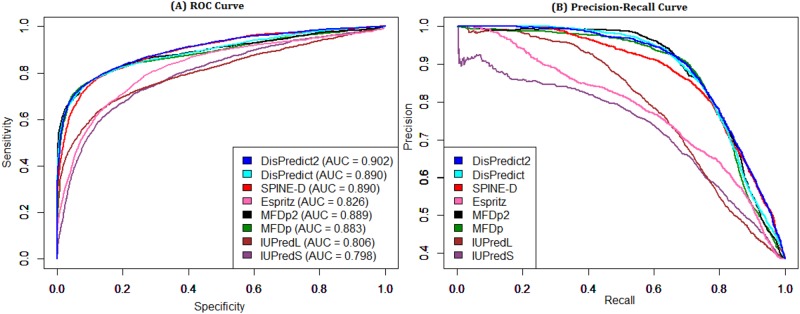
ROC and precision-recall curves given by 8 disorder predictors for DD73 dataset.Comparison of disorder predictors in terms of (A) ROC curve and (B) precision-recall curve on DD73 dataset. The area under ROC curves are given in the plot (A).